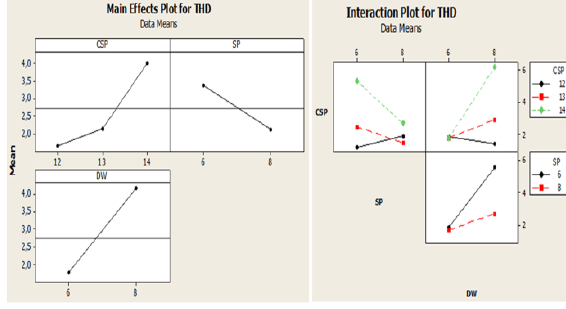
Figure 2. Main effects and interaction plot for THD.